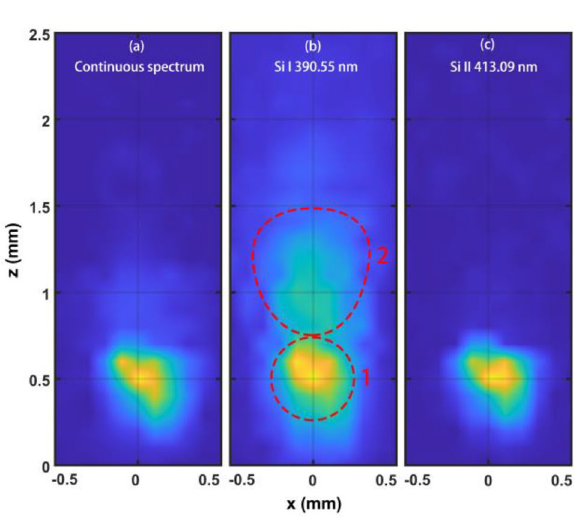
Figure 4. The spatial distribution of the spectral intensity in the plume. ( a ) Continuous spectrum, ( b ) Si I line at 390.55 nm, ( c ) Si II line at 413.09 nm. Each image is normalized to its own maximum